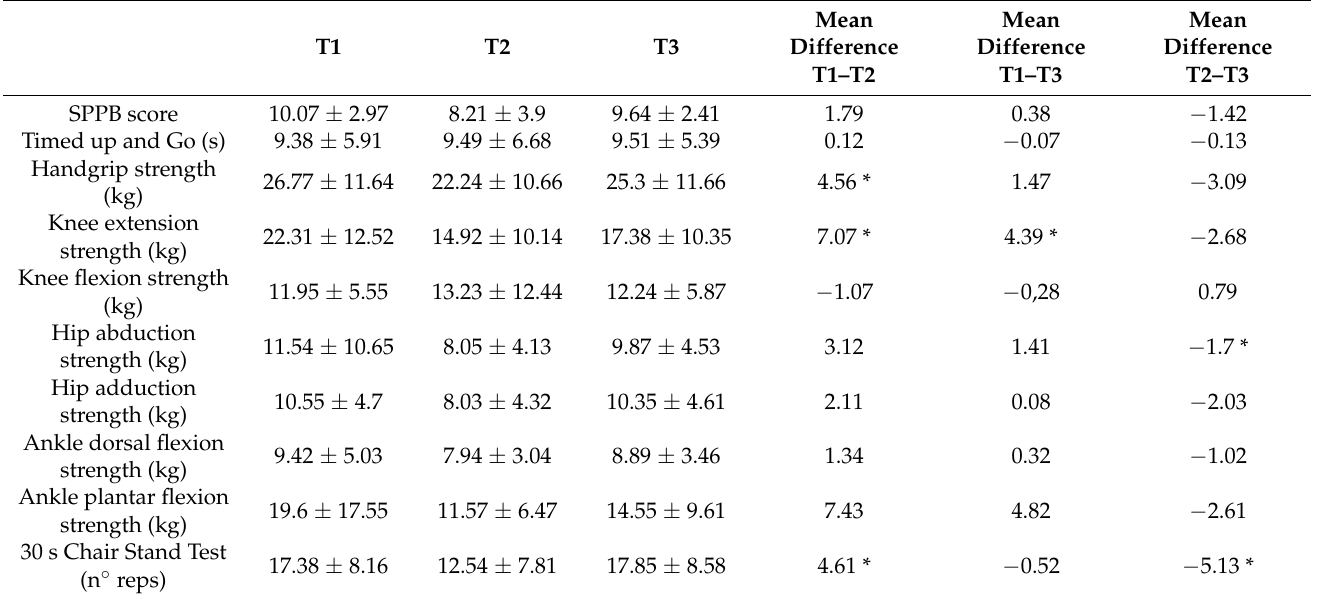
Table 2. Differences in clinical data at the different time points: preoperative one month (T1), postoperative three days (T2) and postoperative one month